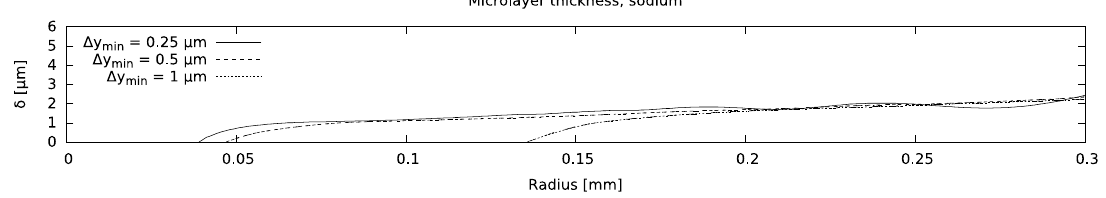
Table 4. Parametric study on microlayer formation.